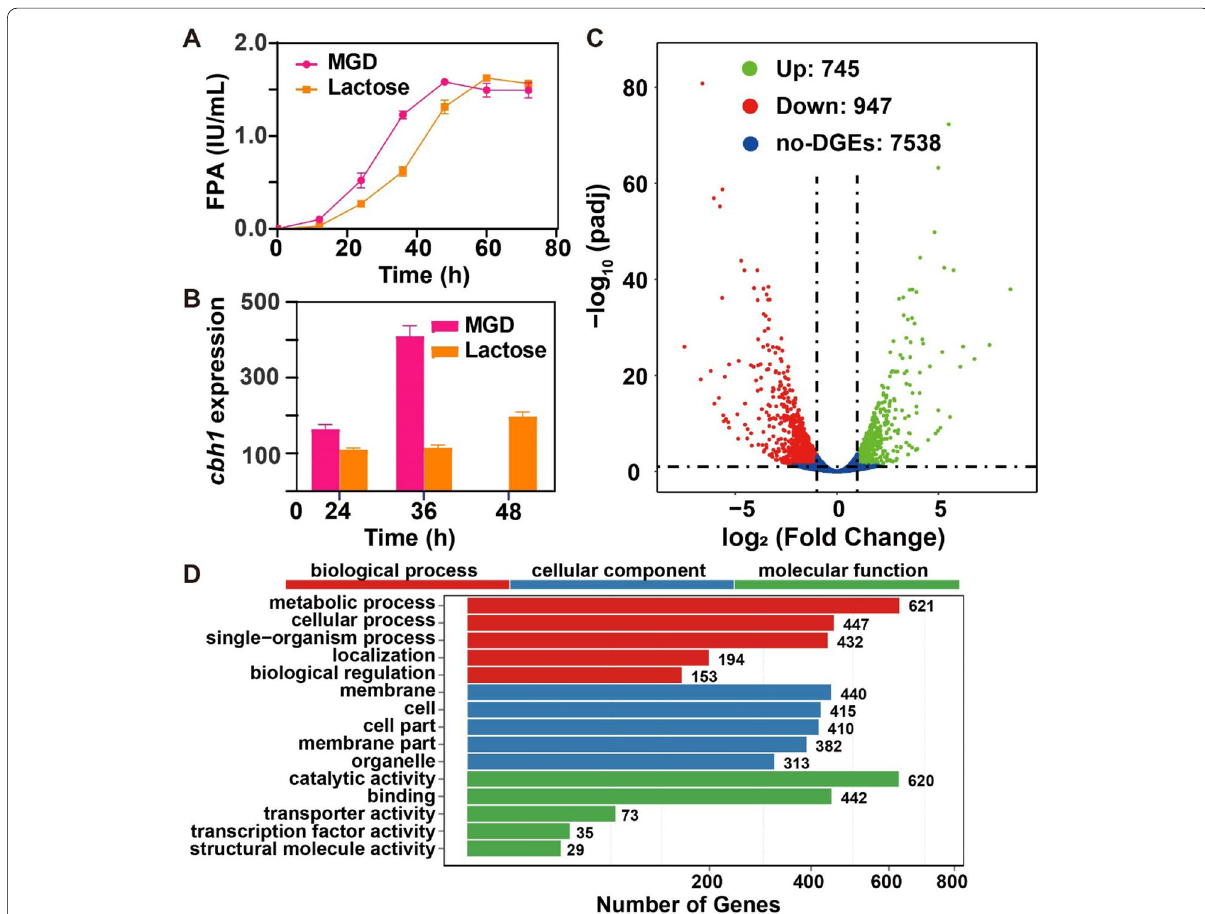
Fig. 1 Comparison of cellulase production ( A ) and transcription of cbh1 encoding cellulase ( B ) in the batch fermentation of the strain T. reesei Rut C30 using 10 g/L MGD or 10 g/L lactose as the inducer and carbon source. C The volcano map shows the comparison of gene expression levels. Green dots represent genes that were significantly upregulated; red dots represent genes that were significantly downregulated; blue dots represent genes for which no significant differences were observed. D Gene Ontology (GO) enrichment analysis of T. reesei DEGs in MGD and lactose. Significantly enriched categories ( P adj < 0.05) are